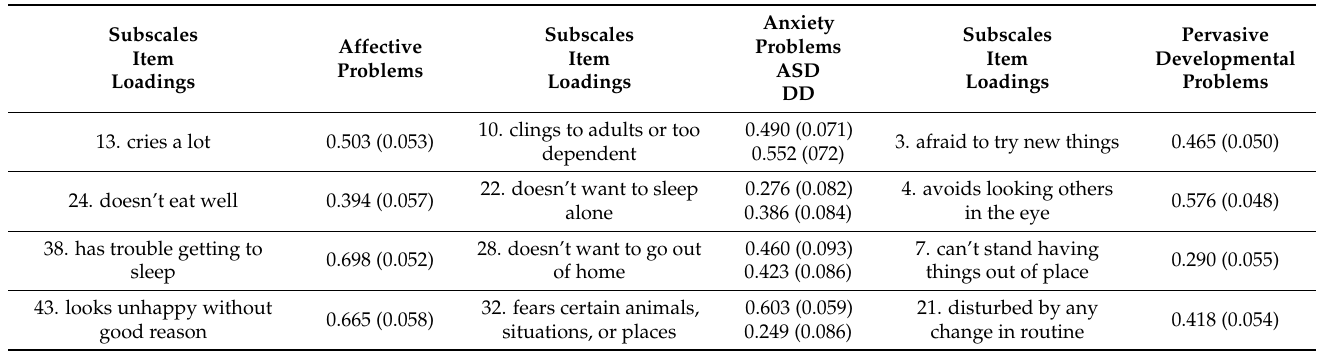
Table A1. Factor loadings in each subscale